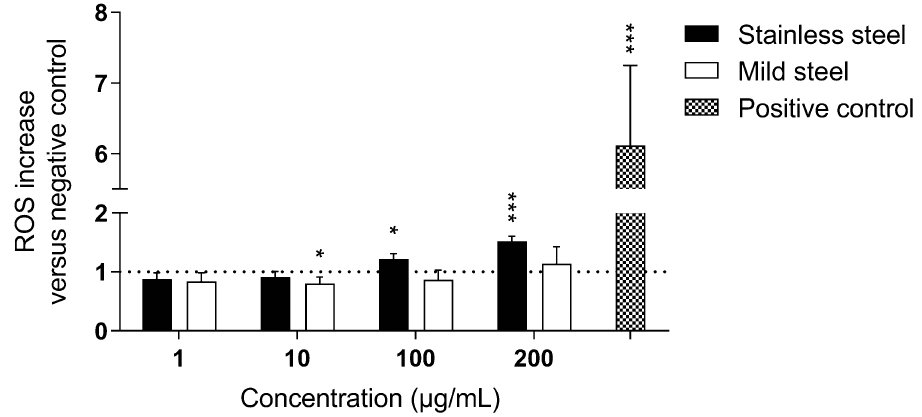
Figure 8. Intracellular ROS production following exposure of primary human small airway epithelial cells to welding particles. ROS production was assessed with the DCFDA reagent. hSAEC cells from three donors were exposed to stainless steel or mild steel particles (1–250 µg/mL) for 24 h. Fluorescent measurements (Ex485/ Em535) were performed every 5 min over 30 min. ROS increase was calculated as mean slope per minute and normalized to the unexposed control. Tert-butyl hydroperoxide (TBP, 200 μM) was used as positive control. The data is presented as mean ± standard deviation of at least two independent experiments for each donor (n = 8). Statistically significant differences are labeled with an asterisk (* for P-value < 0.05, *** for P-value < 0.001). Figure created using GraphPad Prism version